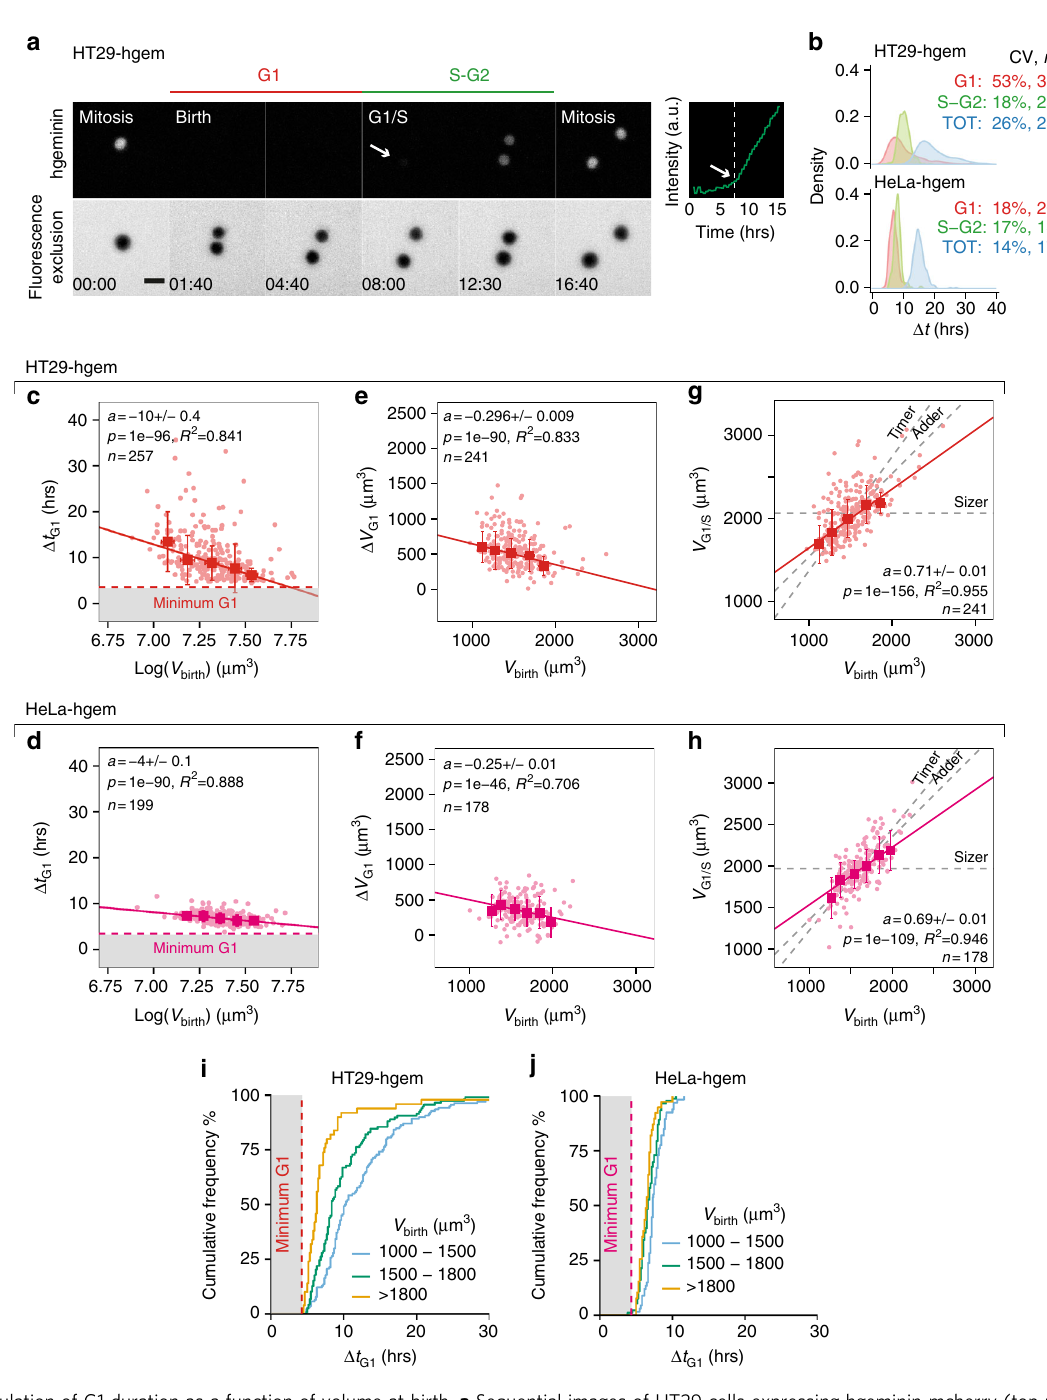
Fig. 4 Modulation of G1 duration as a function of volume at birth. a Sequential images of HT29 cells expressing hgeminin-mcherry (top row) in an FXm chamber (bottom row). Right graph shows the quanti fi cation of hgeminin-mcherry in the cell as a function of time. Time zero corresponds to mitosis. The vertical white dashed line and arrows indicate the time at which hgeminin-mcherry becomes detectable. G1 phase (red line) spans from birth to appearance of hgeminin (G1/S transition) and S-G2 phases (green line) from G1/S to next entry in mitosis. Scale bar is 20 µ m. Time is in hours:minutes. b Kernel density estimates of the duration Δ t of G1 phase (red), S-G2 phase (green) and total cell cycle (blue) for both HT29-hgem and HeLa-hgem. CV is the coef fi cient of variation (in %). c , d Duration of G1 phase, Δ t G1 as a function of the logarithm of volume at birth ( V birth ) for HT29-hgem ( N = 4) ( c ) and HeLa-hgem ( N = 2) ( d ). Red dashed line and gray area are a visual guide for minimum G1 duration around 4 h. e , f Total added volume in G1 Δ V G1 as a function of volume at birth ( V birth ) for HT29-hgem ( N = 4) ( e ) and HeLa-hgem ( N = 2) ( f ). g , h Volume at G1/S ( V G1/S ) vs. volume at birth ( V birth ) for HT29-hgem ( N = 4) ( g ) and HeLa-hgem ( N = 2) ( h ). The dashed gray lines indicate the expected trend in the case of a timer (slope = 〈 V G 1/ S / V birth 〉 , intercept = 0), an adder (slope = 1, intercept = 〈 V G 1/ S 〉 ) and a sizer (slope = 0, intercept = 〈 V G 1/ S 〉 ). i , j Cumulative frequency graph of G1 duration binned for three ranges of volumes at birth V birth for HT29-hgem ( i ) ( N = 4) and HeLa-hgem ( j ) ( N = 2). Dashed line and gray area are a visual guide for minimum G1 duration around 4 h. For the plots in c – h , individual cell measures (dots) and median bins (squares) ± s.d. (bars) are shown. Solid lines are linear regressions on the median bins weighted by the number of observations in each bin. See also Supplementary Figure 4 and Supplementary Movie 3